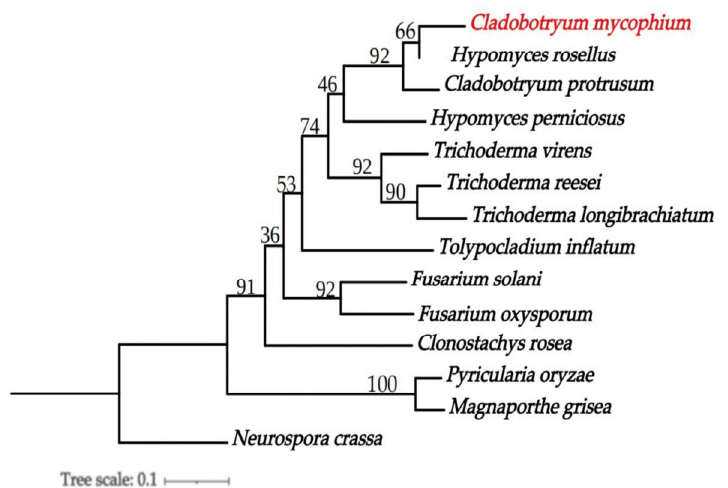
Figure 6. Phylogenetic tree of C . mycophilum and 13 other fungal species. Maximum likelihood (ML) values > 50% were placed close to topological nodes. The tree was rooted to N. crassa . The newly sequenced genome is indicated in red.